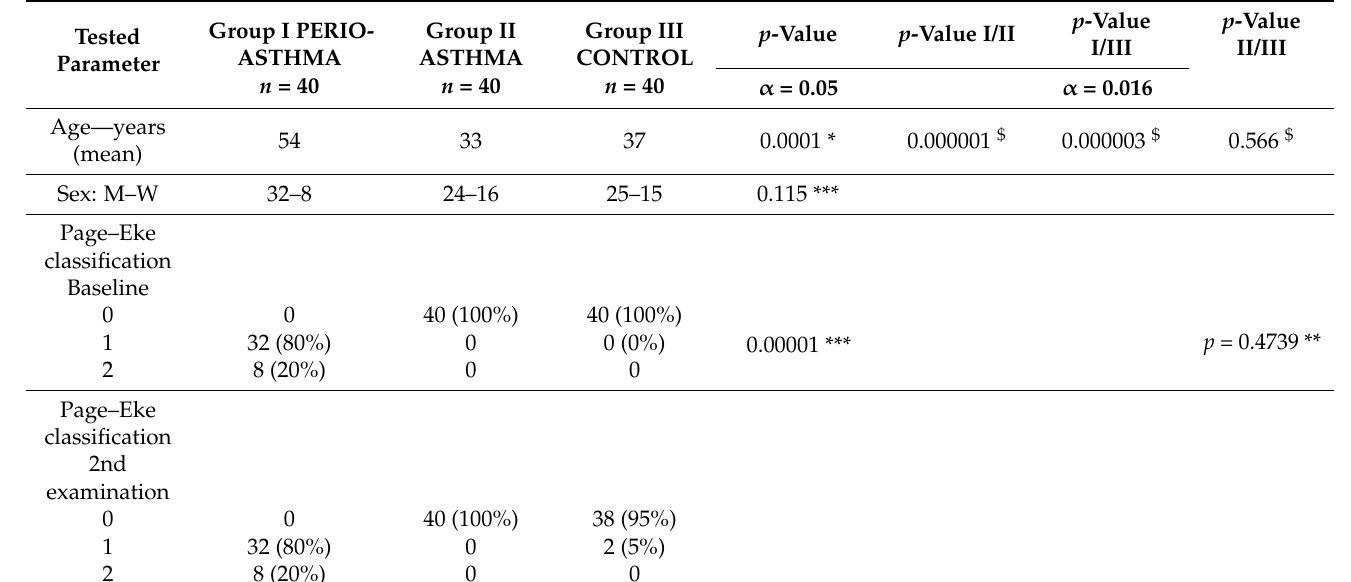
Table 1. Baseline